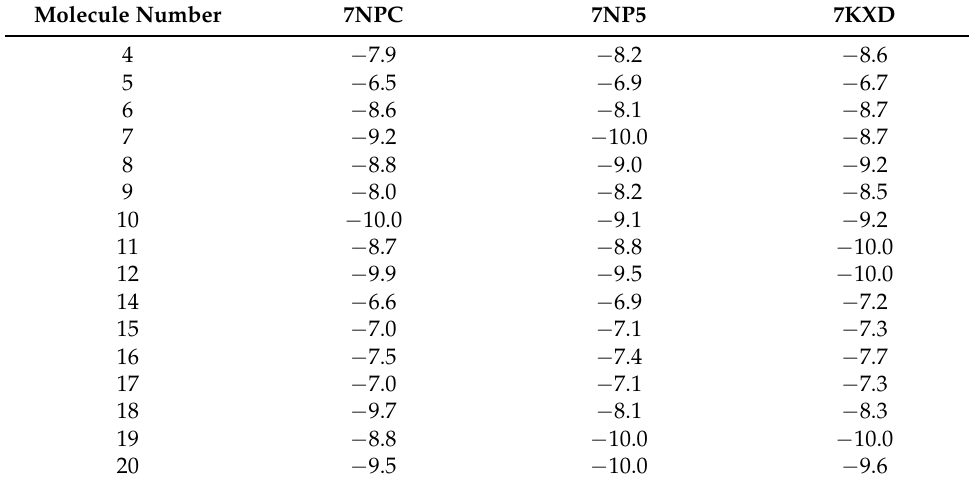
Table 3. Docked structures with docking scores in kcal/mol unit (see SM File S42). Molecule Number